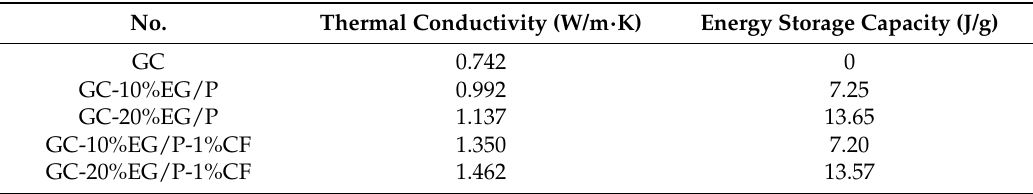
Table 3. The thermal conductivity of EGPG.